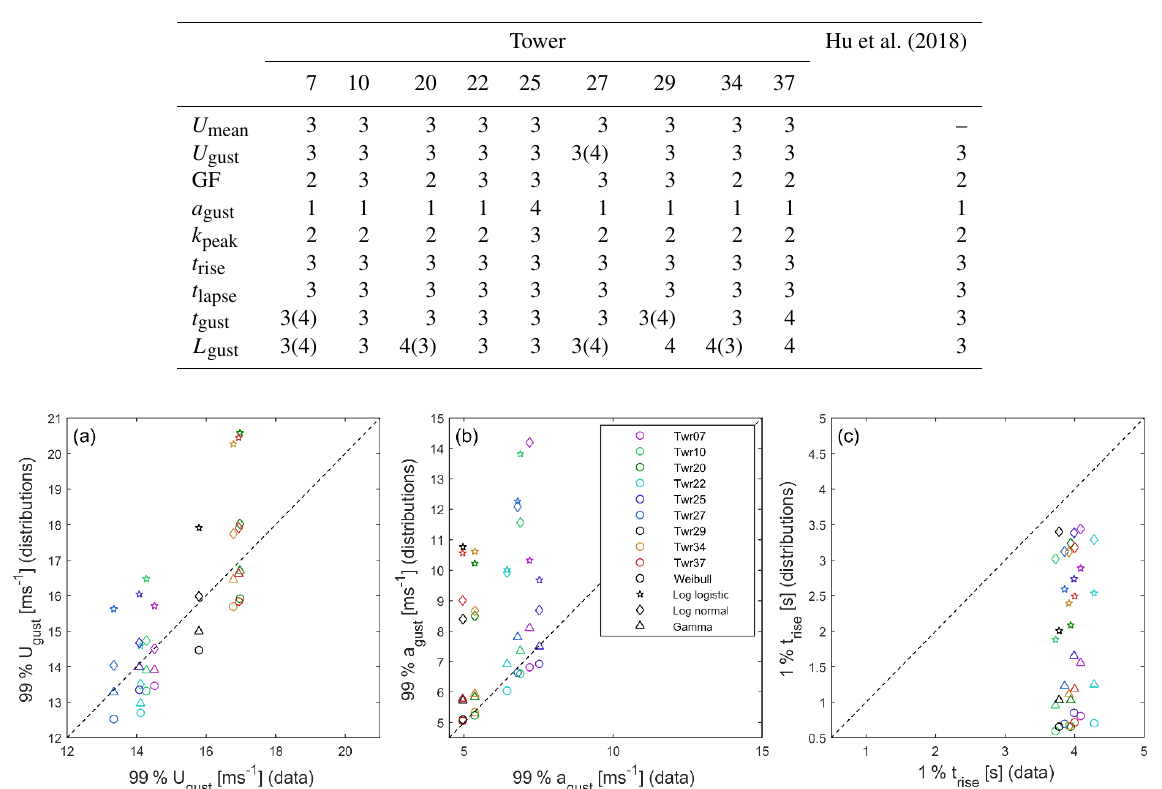
Figure 4. (a) The 99th percentile wind gust magnitude ( U gust ), (b) 99th percentile amplitude ( a gust ), and (c) first percentile rise time ( t rise ) as derived directly from the observations at 60ma.g.l. and estimated from the parametric distributional fits (shown by the different symbols). The towers are denoted by the color scheme introduced in Fig. 1. The dashed line indicates 1 : 1